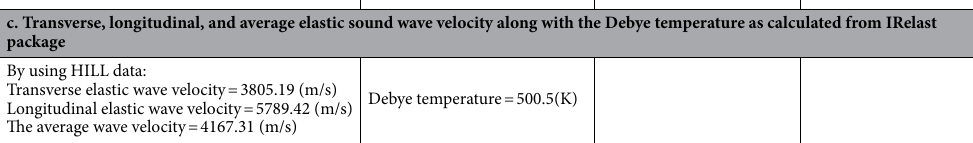
Table 2. The Elastic properties of YFe 3 as obtained from IRelast Package.